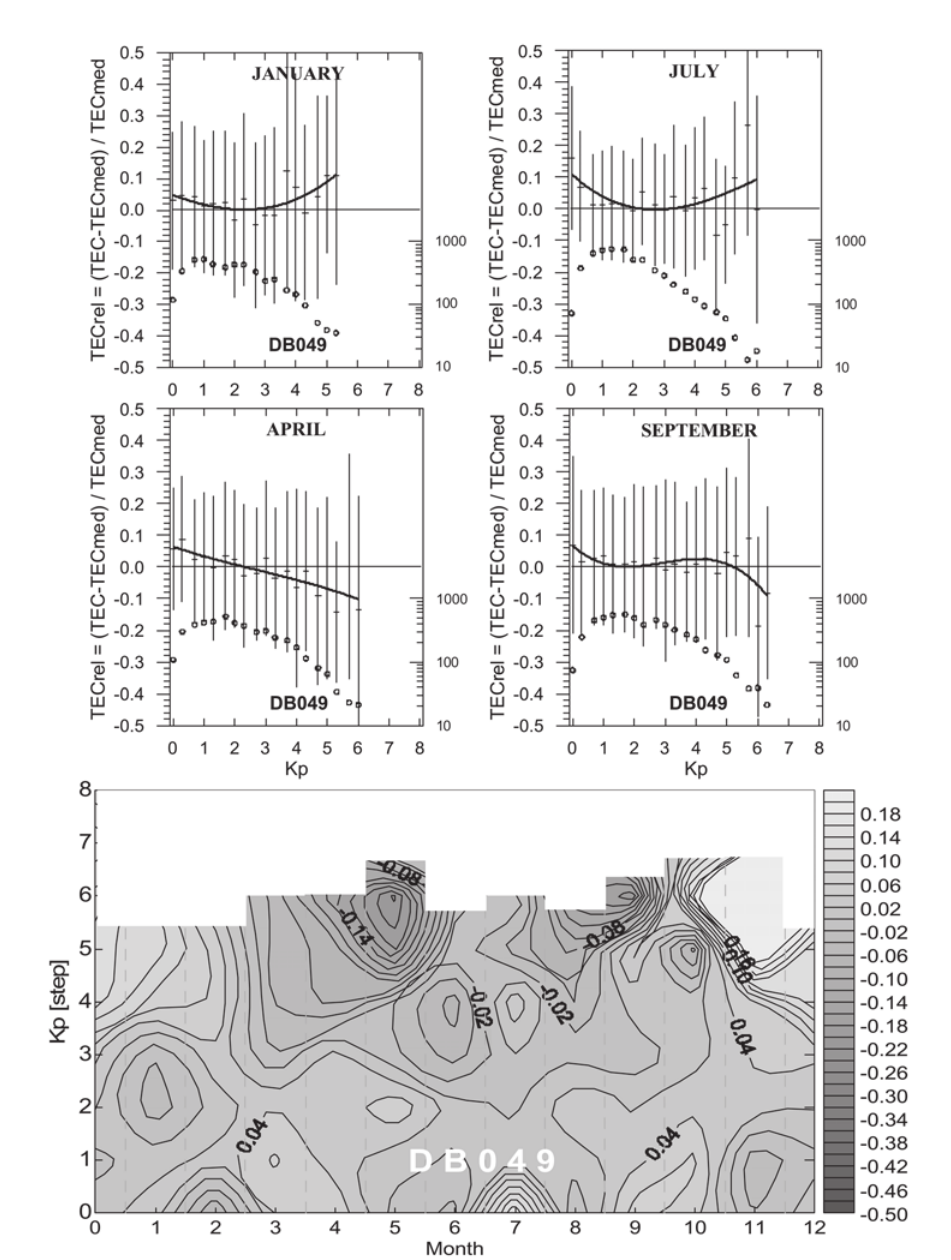
Fig. 6. The GPS TEC relative deviations (TEC ) response to geomagnetic activity for the site of ionosonde rel station DB049 (4.6 ° E, 50.1 ° N) based on data from the 1994-2001 period. The average values of TEC (dashes) rel are approximated by 3 − rd degree polynomials (solid lines). The vertical bars represent the standard deviations (doubled), and circles represent the data number (scaled on the right-hand